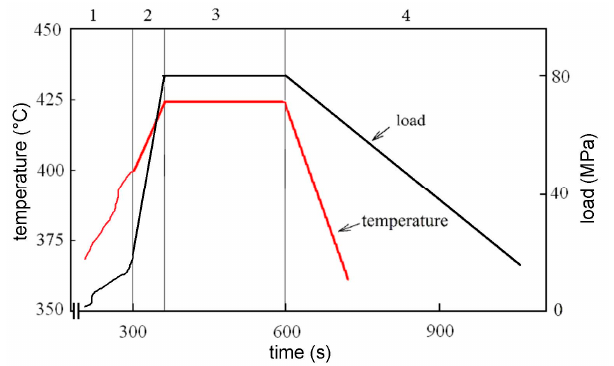
Figure 1. The scheme of the sintering process: 1: set vacuum, free heating to 400 °C, applying an initial load of 20 MPa; 2: increase in temperature and load (60 s); 3: holding at a temperature of 425 °C and a load of 80 MPa (240 s); 4: free cooling and parallel unloading.